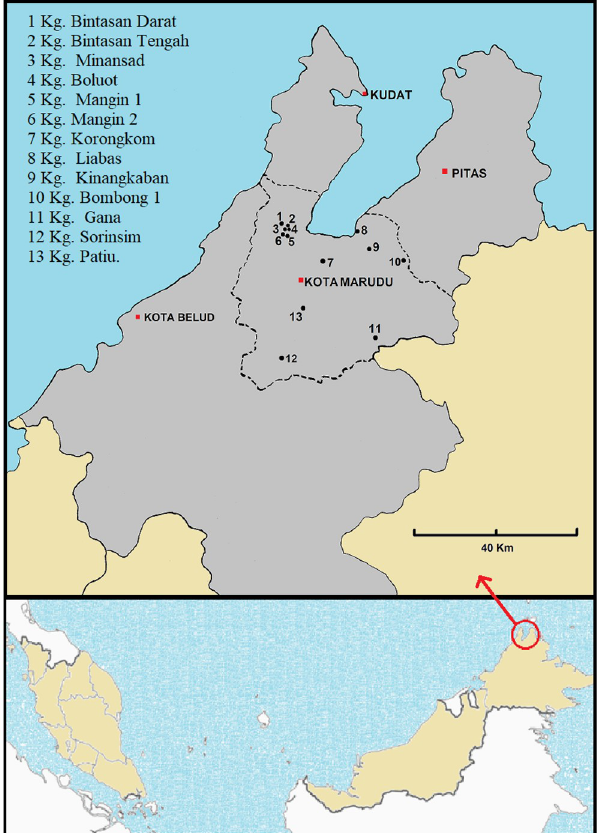
Fig 1. Map of Kota Marudu district, Sabah where the study was conducted, indicating the location of the villages. The figure was modified using a map available from http://www.supercoloring.com/coloring-pages/malaysia-map, and the village location plotted with Google earth